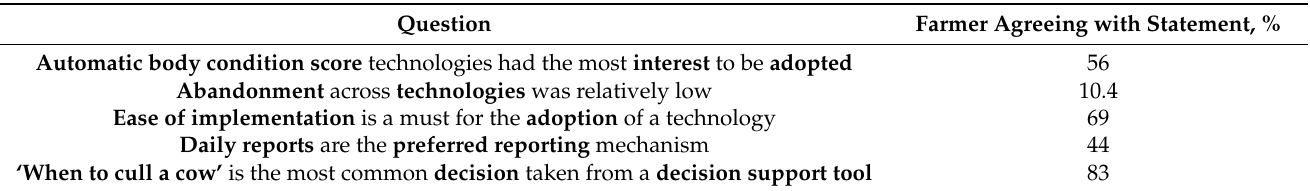
Table 3. Response summary of the technologies and decision support tools: adoption and